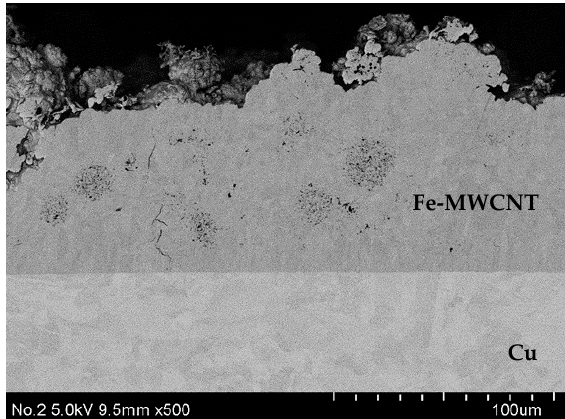
Figure 6. Cross-sectional SEM image of Fe–MWCNT composite plating layer.